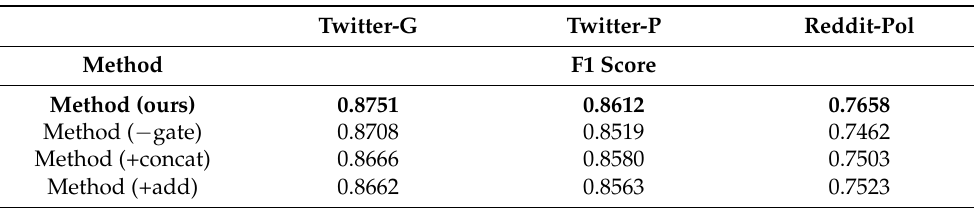
Table 6. Experimental results of ablation study concerning the gate mechanism. The best result is in